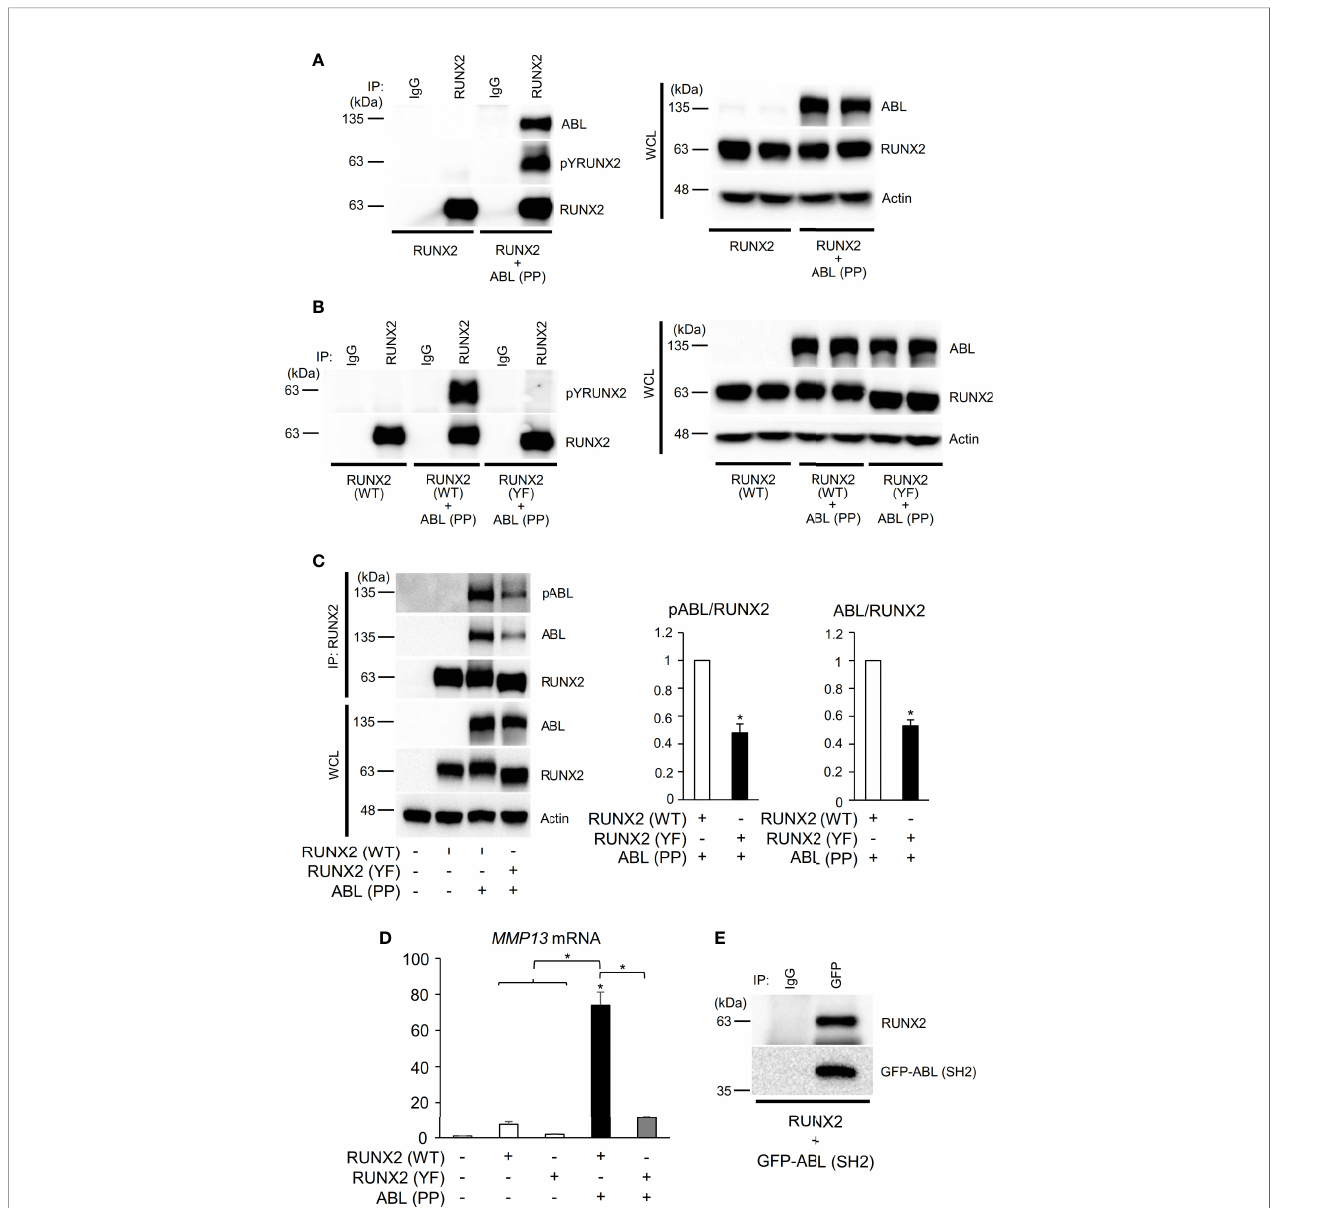
FIGURE 2 | ABL binds to, phosphorylates, and activates RUNX2 through its SH2 domain. (A – C) HEK293T cells were co-transfected with wild-type (WT) or all tyrosine to phenylalanine mutant (YF) RUNX2 with or without ABL (PP). RUNX2 immune complexes were probed with an anti-phosphotyrosine (4G10), anti- pY245ABL, anti-ABL or anti-RUNX2 antibody. Whole cell lysates (WCL) were probed with the indicated antibodies for Western blot analysis. (D) Quantitative PCR analysis of MMP13 mRNA expression in HEK293T cells co-transfected with RUNX2 (WT or YF) with or without ABL (PP). n = 3. (E) HEK293T cells were co- transfected with RUNX2 with or without GFP-ABL (SH2). GFP-ABL (SH2) immune complexes were probed with an anti-RUNX2 or anti-GFP antibody. P values were determined by ANOVA with Tukey – Kramer ’ s post hoc test. Data are presented as means ± SEM. *P <